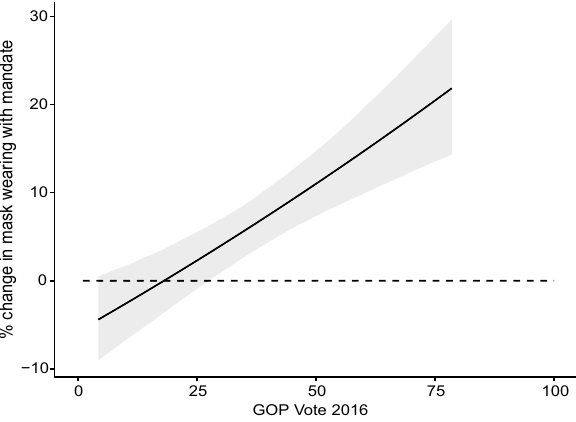
Figure 4. Marginal Effect of Mask Mandates for Varying GOP County Vote. Shaded areas represent 95% confidence